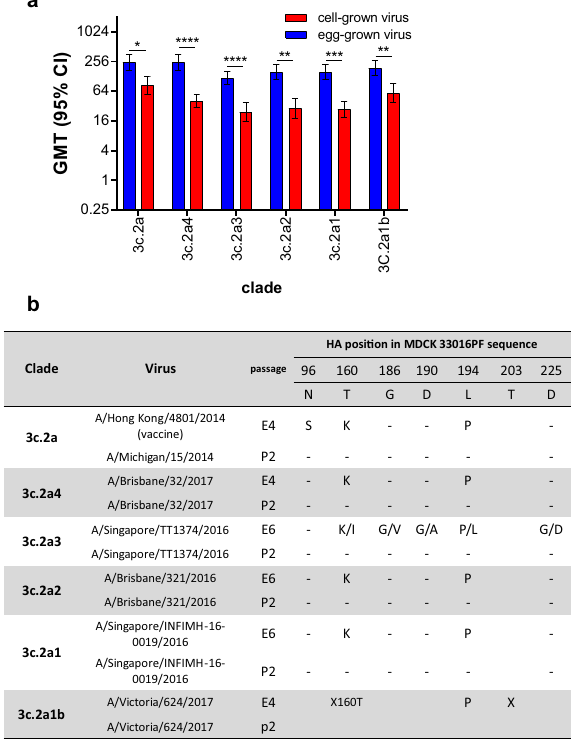
Fig. 7 Assessment of impact of egg adaptation on antigenicity. a Analysis of post-vaccination serological responses to egg- and cell- grown virus pairs. Twenty human post-vaccination sera were tested by HI assay against the indicated virus. The Geometric Mean Titre (GMT) and 95% con fi dence interval was calculated for each virus assessed. b Amino acid mutations in the HA-1 sequence, as compared to the cell sequence is shown for each virus included in ( a ). * p < 0.05, ** p < 0.01, *** p < 0.001, **** p < 0.0001. The difference in GMT was assessed using a multiple t